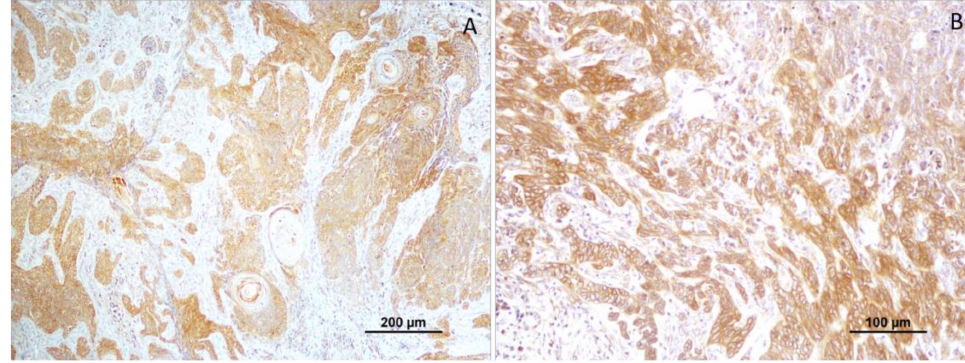
Figure 4. ( A, B ) Positive CTEN immunoreactivity in poorly differentiated tumors (grade III). Analyzing the association of CTEN immunoreactivity and the histological grading of the tumors, a significant association of the higher tumor grading (poorly differentiated tumors) with CTEN immunoreactivity was noted, which was statistically significant ( p < 0.0001). A possible association between CTEN expression and the localization of the tumors (cutaneous/oral) was also evaluated. However, the differences between CTEN expression in cutaneous and oral tumors were not statistically significant ( p = 1); Figure 5.